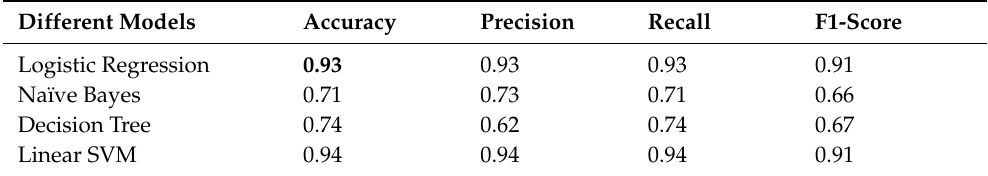
Table 7. Experimental results for “Trust Network Reconstruction”.